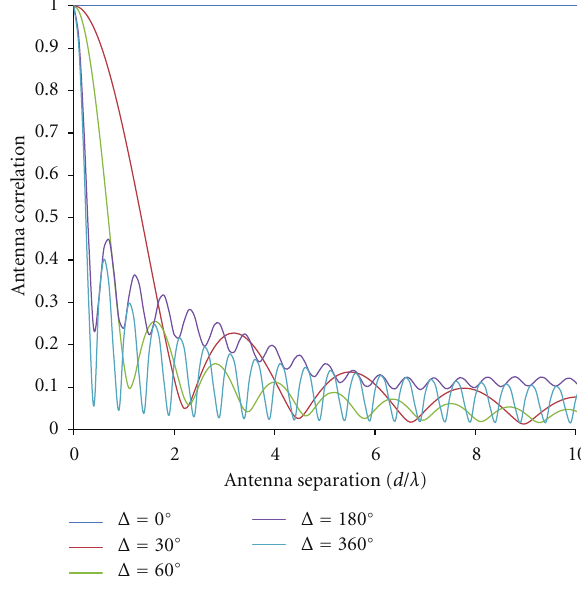
Figure 5: Antenna correlation for θ 0 = 60 ◦ .